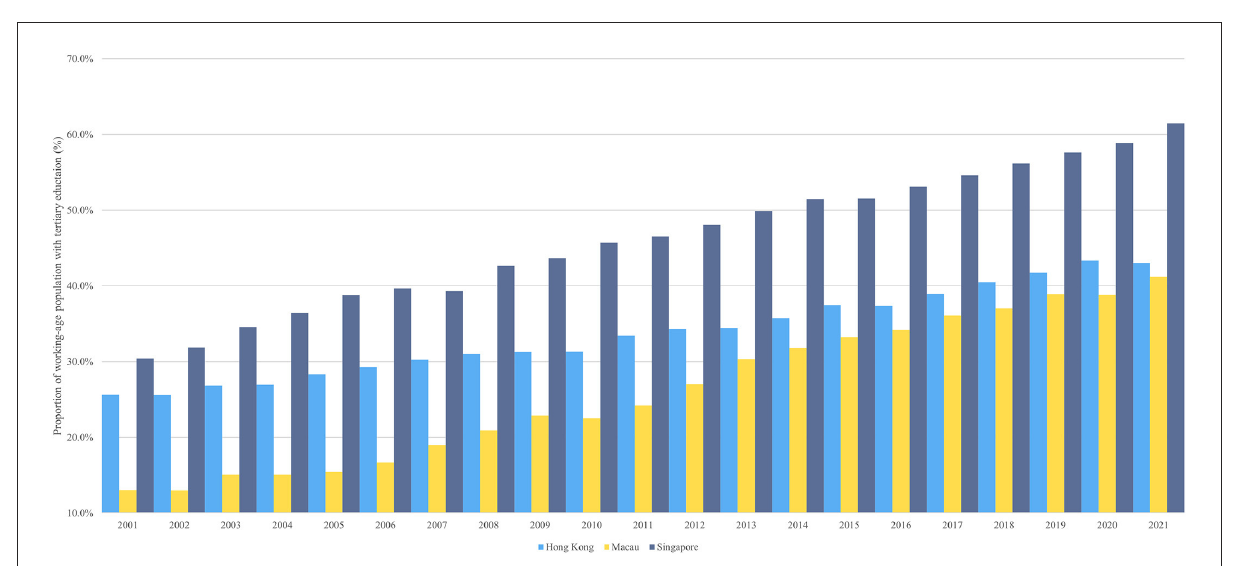
FIGURE3 Proportion of working-age people with tertiary education.